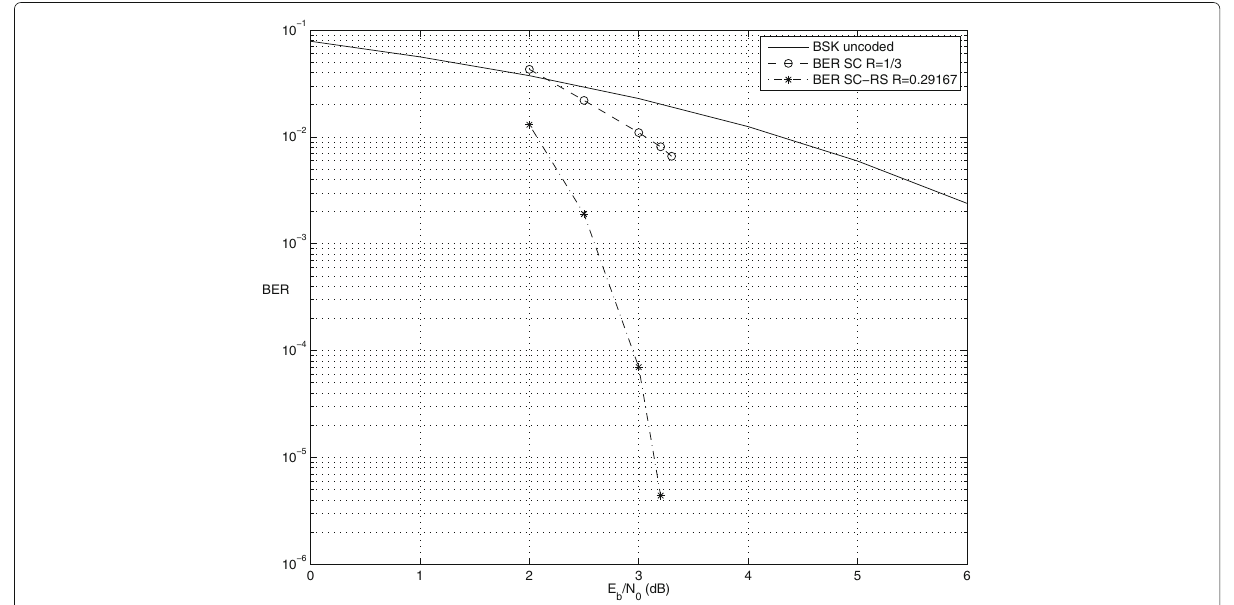
Fig. 2 BER versus E b for the uncoded, SC, and SC-RS architectures. The code rate is 0.29167 N 0